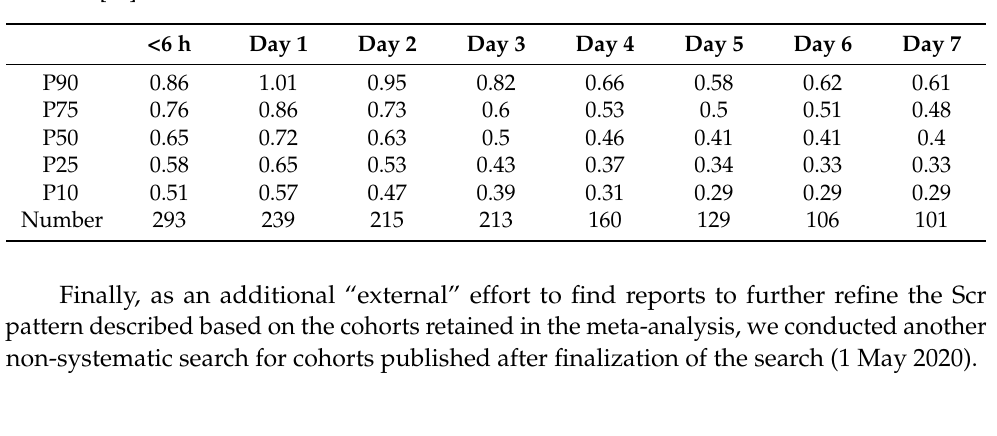
Table 1. Centile serum creatinine values (Scr, mg/dL, 90th, 75th, 50th, 25th, and 10th) at birth, and during the consecutive days in early neonatal life (until day 7), based on 1456 Scr observations in 495 (near)term cases (gestational age ≥ 36 weeks), extracted from a previously reported data set of neonates